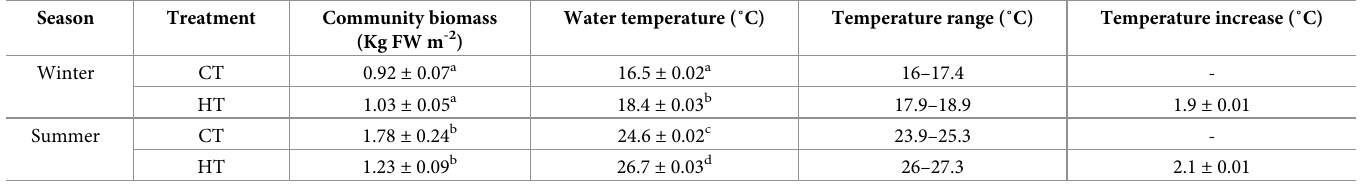
All data are expressed as mean ± SE. CT: Control temperature; HT: High temperature. Superscript letters (a, b, c, d) indicate significant differences between treatments and seasons at α =